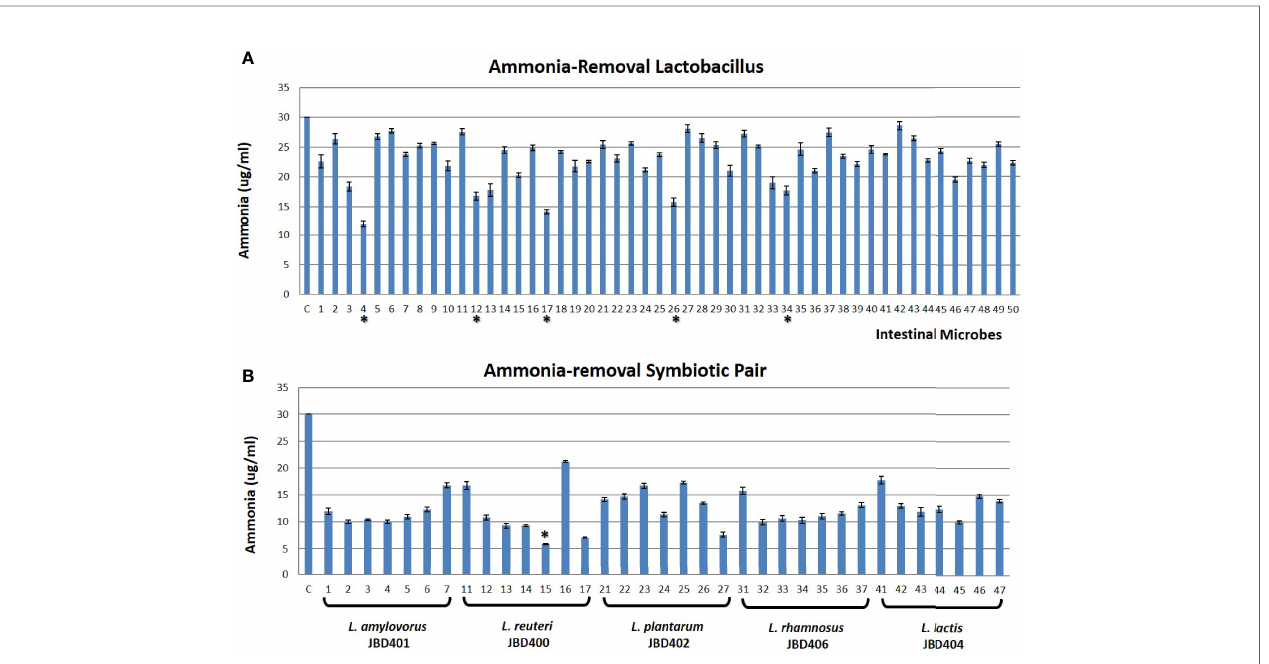
FIGURE 2 | In vitro identi fi cation of a symbiotic pair of ammonia removal microbes. (A) The in vitro screening result of Lactobacillus strains (Gut Microbiota Bank) having an ability to absorb ammonia from its surrounding environment. X-axis showed untreated control (C) and 50 tested Lactobacillus as shown in Table S1 while Y-axis is the ammonia concentration in the media. The top 5 Lactobacillus strains with strong ammonia-removal capacity were indicated as *. (B) The representative fi gure of the ammonia-removing ability of Lactobacilli with symbiotic partners (Gut Microbiota Bank) in vitro . X-axis indicated untreated control (C) and L. amylovorus JBD401 (No. 1~7), L. reuteri JBD400 (No. 11~17), L. plantarum JBD402 (No. 21~27), L. rhamnosus JBD406 (No. 31~37), and L. lactis JBD404 (No. 41~47) alone (1, 11, 21, 31, 41) or with symbiotic partner S. mutans JBD423 (No. 2, 12, 22, 32, 42), S. ratti JBD428 (No. 3, 13, 23, 33, 43), S. intermedius JBD429 (No. 4, 14, 24, 34, 44), S. rubneri JBD420 (No. 5, 15, 25, 35, 45), S. lutetiensis JBD421 (No. 6, 16, 26, 36, 46), or S. pneumoniae JBK1-00101 (No. 7, 17, 27, 37, 47) while Y- axis is the ammonia concentration in the media. The symbiotic pair with the best ammonia-removal capacity was indicated as *. All data were expressed as the mean ± SD, as